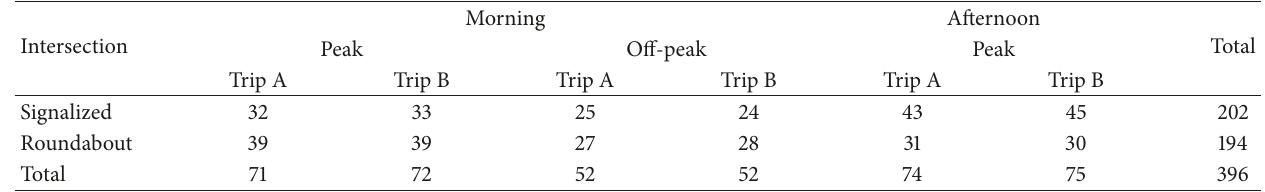
Table 4: Dataset of trips used for the analysis [4].